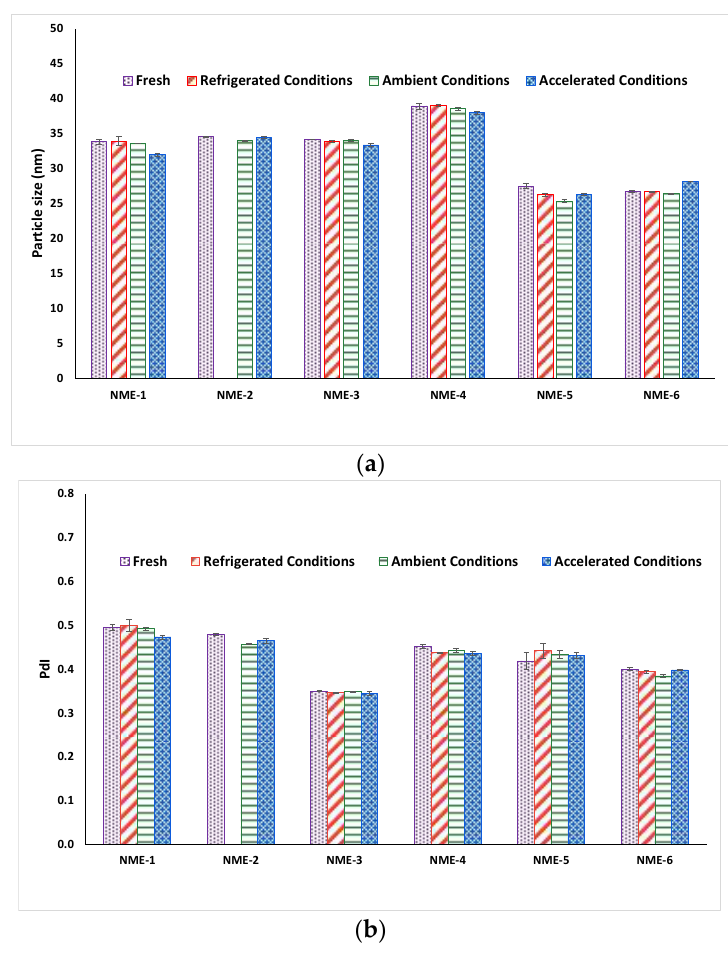
Figure 5. ( a ) Particle size and ( b ) PdI of freshly prepared naringin-loaded microemulsions and after one month storage at refrigerated conditions, ambient conditions, and accelerated conditions, respectively. Data represent mean ± SD (n = 3). Particle size and PdI of NME-2 at refrigerated conditions after one month were not measured because of naringin precipitation.